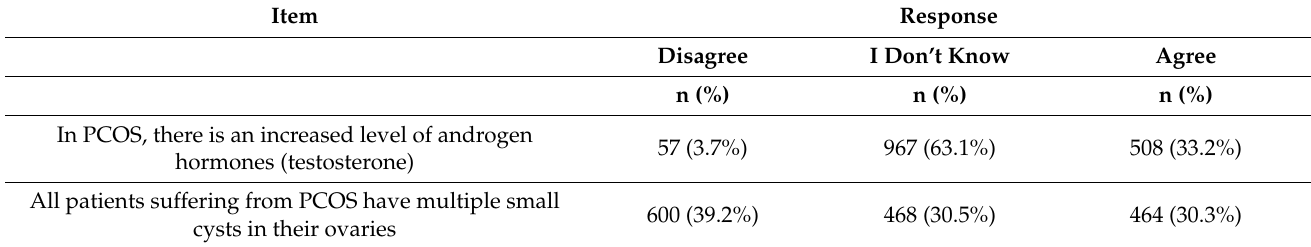
Table 2. Overall knowledge of PCOS among recruited